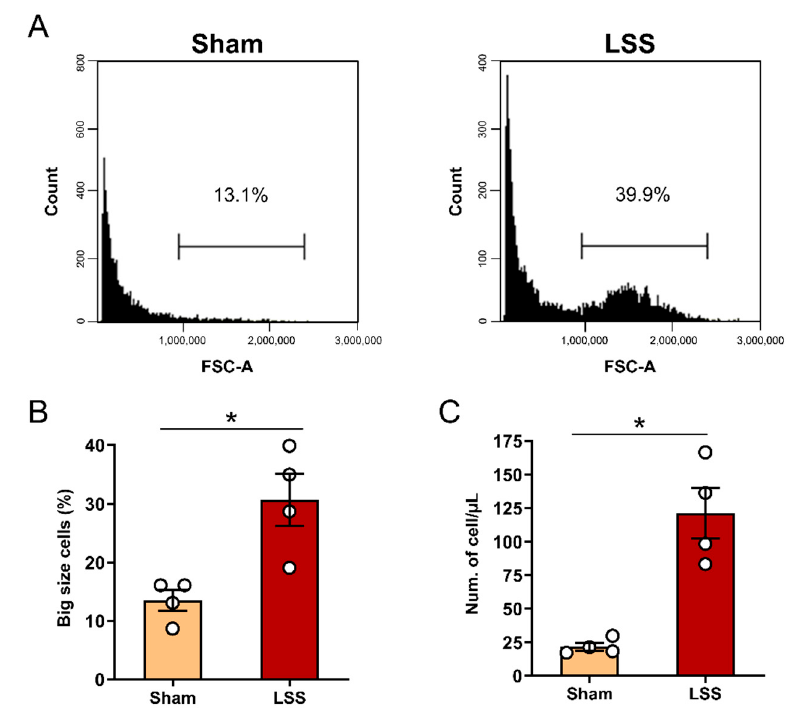
Figure 2. Flow cytometric cell number and size analysis in CSF after LSS. ( A ) Representative flow cytometry dot blot of the cell number and size in sham and LSS groups using the forward scatter (FSC) parameters. ( B ) Flow cytometric percentages of large cells and ( C ) number of cells per 1 µL within the CSF in sham and LSS groups. Data are expressed as the means ± SEM. Significant differences indicated as * p < 0.05 vs. the sham group were analyzed via unpaired t test with Welch’s correction.